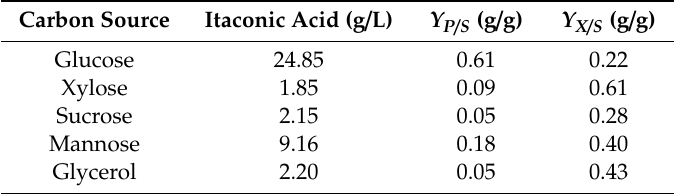
Table 2. Itaconic acid concentration and yield and biomass yield for the fermentations with A. terreus using di ff erent carbon